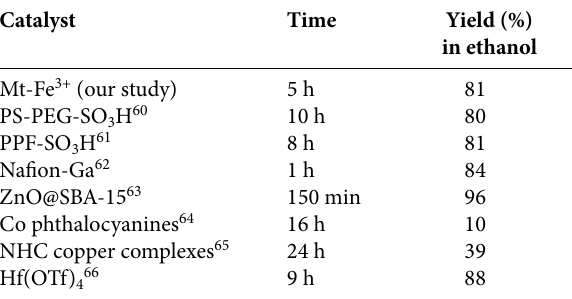
Table 7. Comparison between Mt-Fe 3+ and other catalysts reported in the literature.